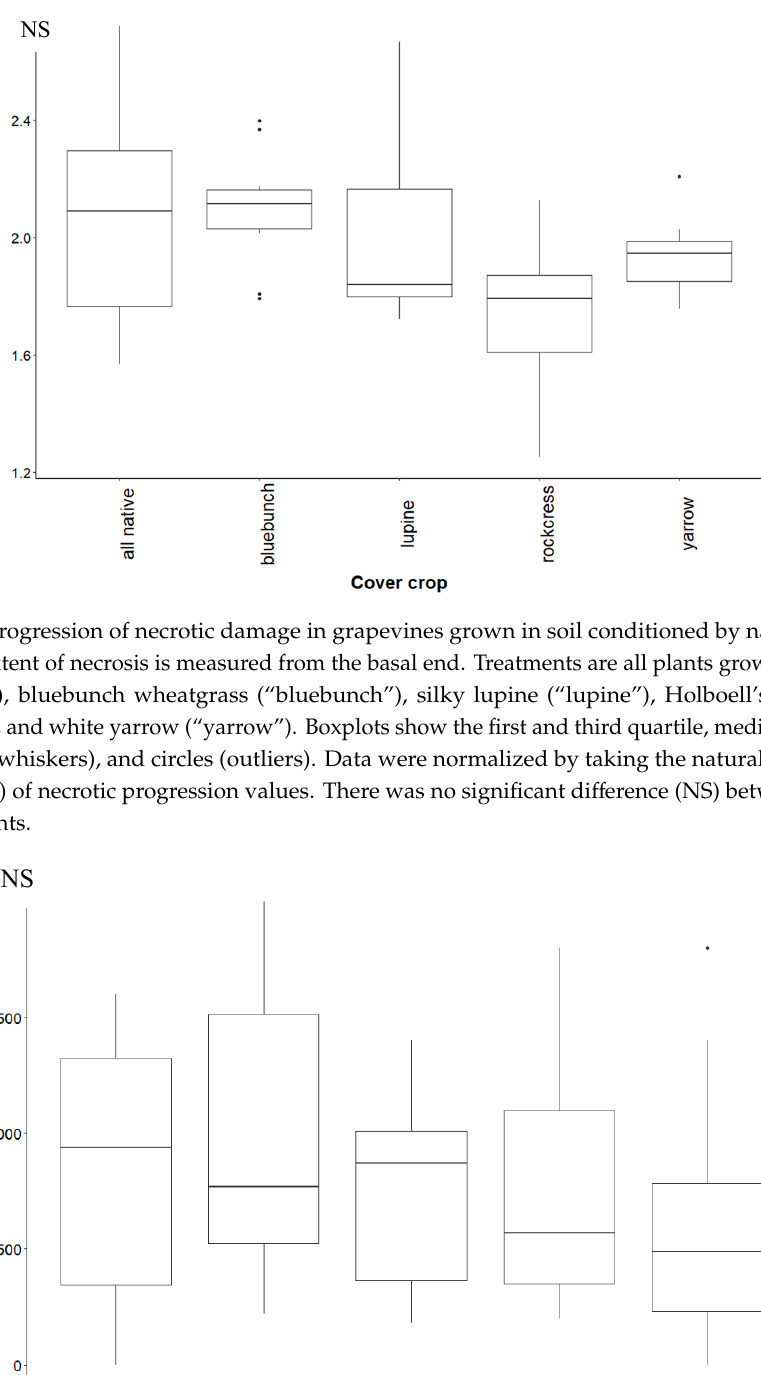
Figure A4 . Recovery of I. liriodendri DNA from native study Chardonnay roots. Treatments are all plants grown together (“all native”), bluebunch wheatgrass (“bluebunch”), silky lupine (“lupine”), Holboell’s rockcress (“rockcress”), and white yarrow (“yarrow”). Data were normalized by taking the square root of the copy number then removing outliers using Tukey’s interquartile range (IQR). Copy number did not differ significantly (NS) between cover crop treatments ( p = 0.109).